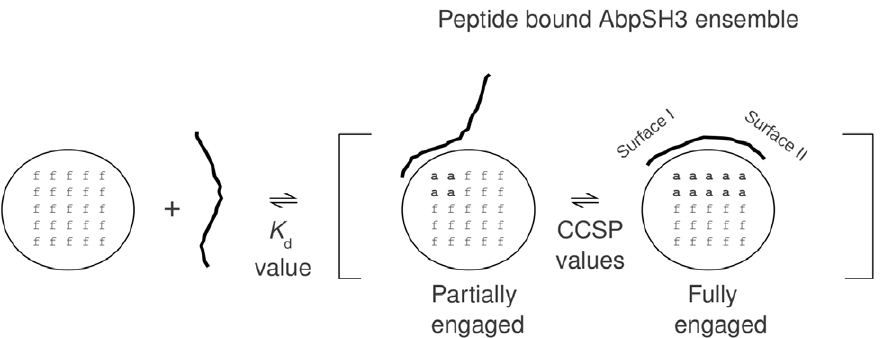
Figure 3. Dynamic exchange model for peptide bound conformers that is consistent with the CCSP phenomena. AbpSH3 is represented by a circle with 25 residues that either exist in the f or a residue-level conformer. When peptide (drawn as a line) binds and saturates the domain (indicated by the bracketed region), as dictated by its dissociation constant K d , different peptide bound AbpSH3 conformers can exist in dynamic equilibrium, as dictated by the residue CCSP values. The relative population of each protein conformer is likely influenced by the local binding energy of each region within the particular peptide that binds. It should be noted that an idealized protein conformer with all relevant residues either completely in the f or all relevant residues completely in the a conformer likely never exists on its own due to the inherent dynamical nature of proteins and as such the peptide-free and fully engaged AbpSH3 conformers modeled by the peptide-free AbpSH3 and the ArkA-AbpSH3 complex in this figure can only be approximations.